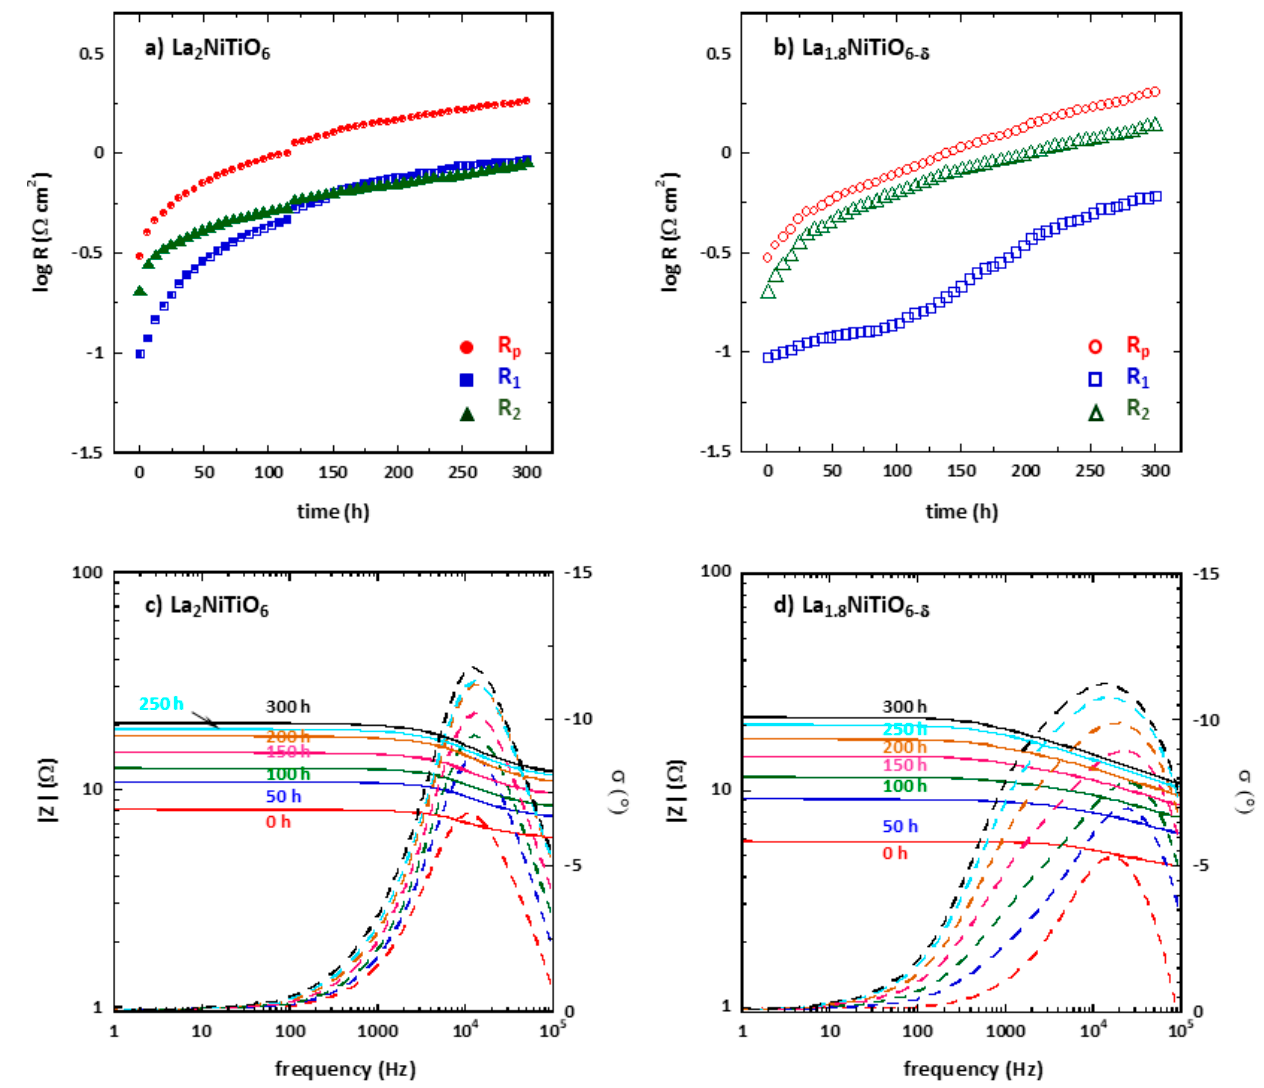
Figure 6. Time degradation of R p (red), R 1 (blue) and R 2 (green) of La 2 − x NiTiO 6 −δ :YSZ/YSZ/La 2 − x NiTiO 6 −δ :YSZ symmetrical cells for ( a ) x = 0 and ( b ) x = 0.2 at 1173 K and ambient air. Element circuit #1 (R 1 , blue) and #2 (R 2 , in green). Bode plots for ( c ) x = 0 and ( d ) 0.2 at 1173 K and ambient air at different times.